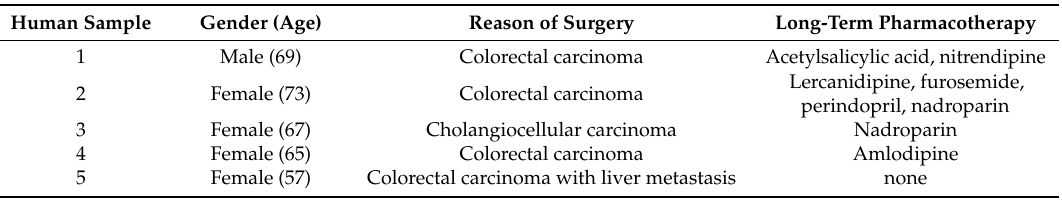
Table 1. Summary of human